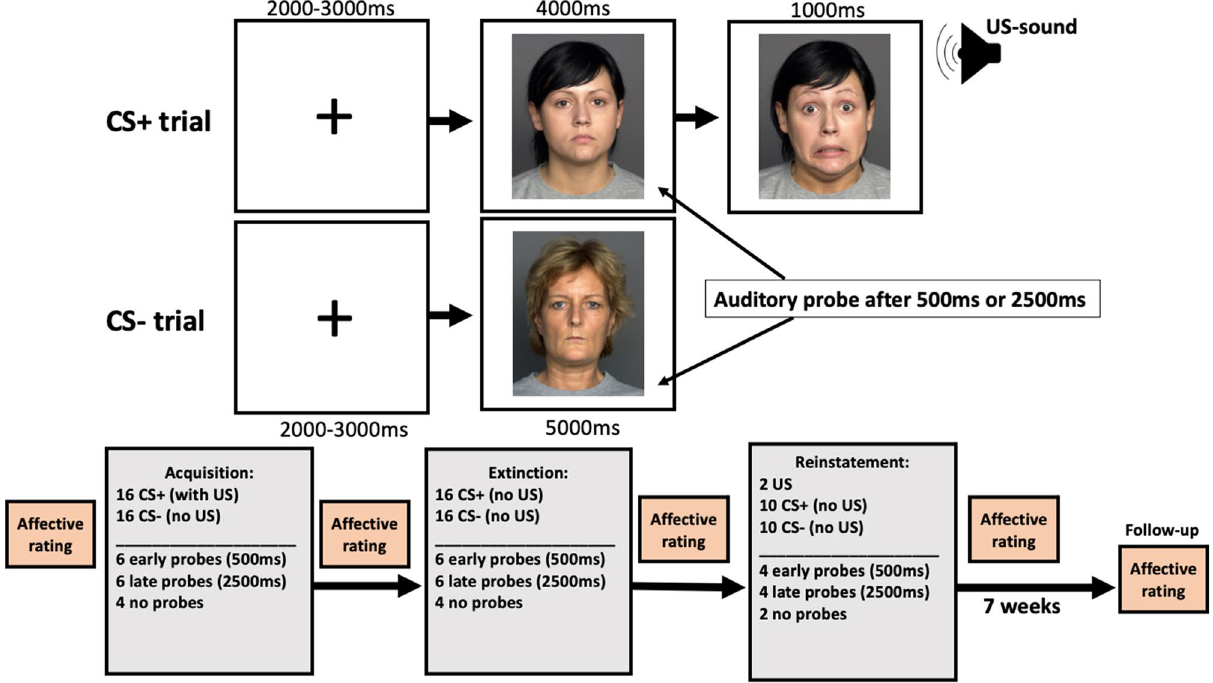
Figure 1. Experimental design. The top panel shows the outline of each experimental trial during the acquisition phase. A brief fixation cross was shown on the screen followed by an image of a neutral female face. During CS+ trials the presentation was followed by an aversive sound (scream) accompanied by the same face with a fearful expression. During CS− trials only the neutral expression was shown and no sound was played. During CS presentation, response times were probed after either 500 ms or 2500 ms by playing a brief 440 Hz tone. Participants were instructed to press the space-bar as quickly as possible when the probe was played. Trials during extinction and reinstatement had the same structure but the US (sound and fearful expression) was always omitted. The face-images shown in the figure are sample images from the FACES database, but not the same as the ones used in the experiment. The bottom panel illustrates the outline of the entire experiment, including number of trials of each type for each experimental